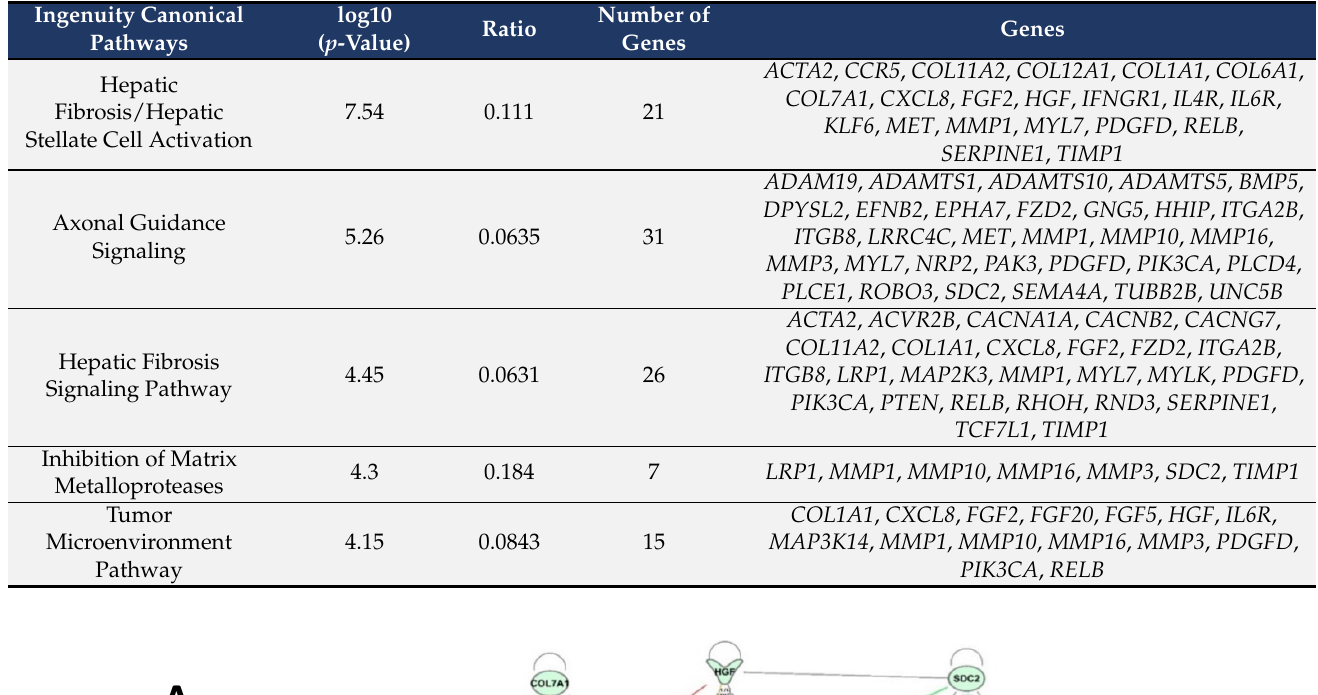
Table 2. Top five canonical pathways generated with the 655 significant deregulated RNAs in RBPMS SG2 vs. EV clones.